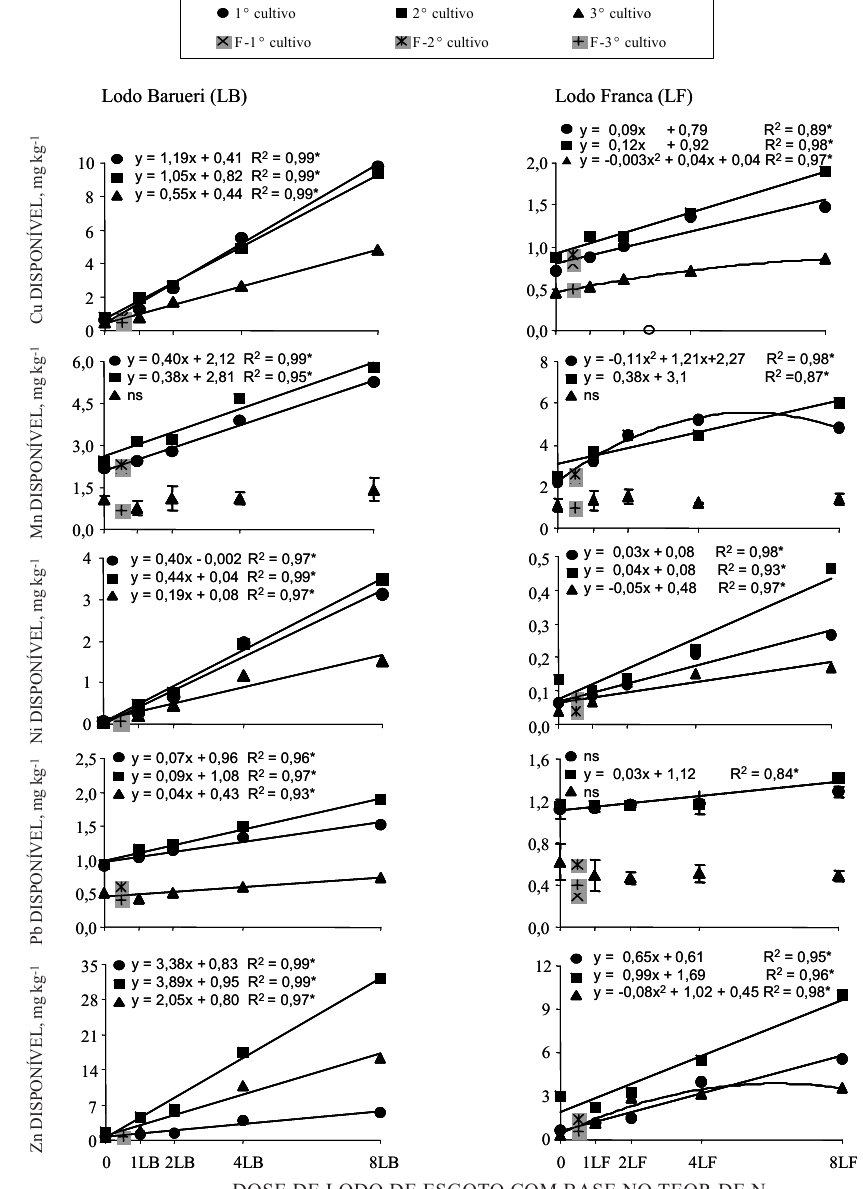
Figura 1. Teores disponíveis pela solução de DTPA de Cu, Mn, Ni, Pb e Zn em Latossolo sucessivamente tratado com lodos de esgoto e cultivado com milho (* Modelo ajustado significativo a p ≤≤≤≤≤ 0,05 pelo teste F; ns = não- significativo; F = adubação mineral com NPK recomendada para a cultura do